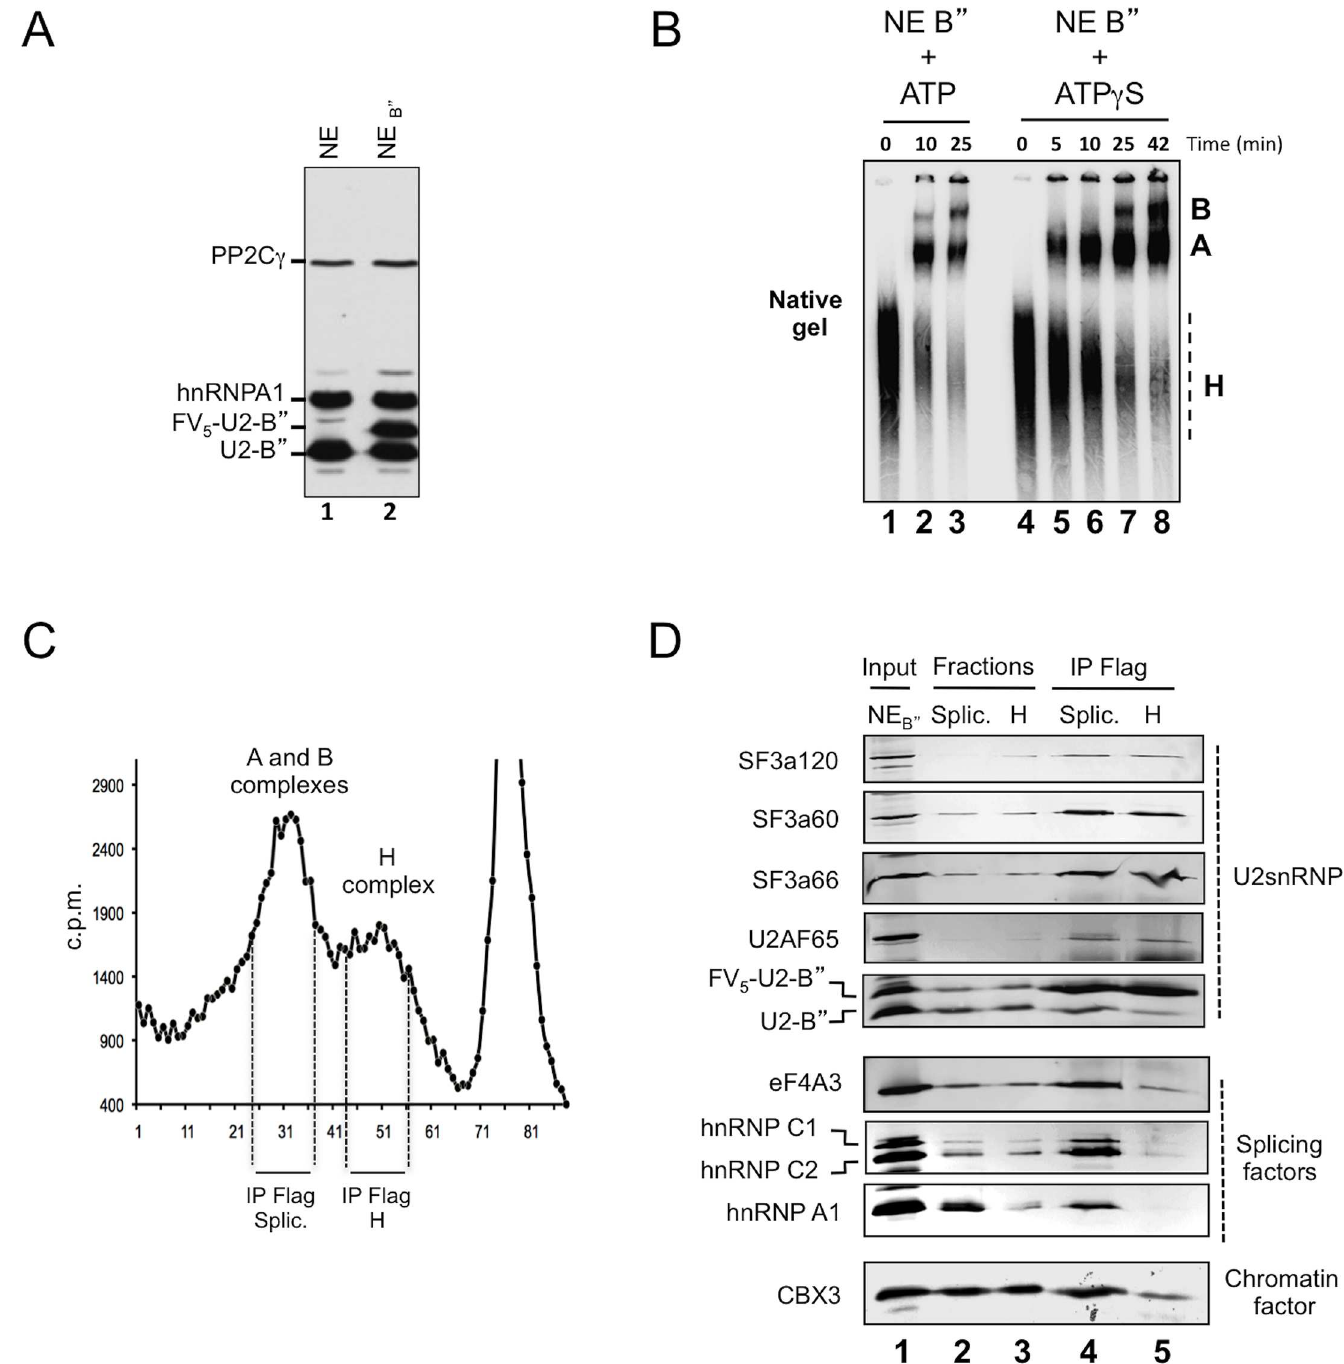
Fig 1. Purificationof spliceosomecomplexesassociatedwiththe U2 snRNP. (A) Detectionby westernblot of indicatedsplicing factors in nuclear extracts fromHeLa S3 cells eitherWT (NE) or stably transducedwith FV 5 -U2-B (NE B” ). (B) Comparison of the kineticand qualityof spliceosome assembly on a radiolabeled AdML pre-mRNAreporterin the presence of eitherATP (lanes1–3) or ATP- γ S (lanes 4–8).Spliceosome complexes A and B were resolved fromunspecificRNP (H complex) on a native gel. (C) Spliceosomecomplexes were purifiedby Sephacryl-S500 gel filtrationfroman in vitro - splicing reactioncomposedof NE B” and radiolabeledAdML reporterincubatedfor 45 min in the presenceof ATP- γ S. Fractions with spliceosome and H complexes selectedfor anti-FLAG immunoprecipitationare indicated. Degraded RNAs and freeproteinsappearin fractions68 to 80. (D) Spliceosome complexes anchoredto the U2 snRNP. NE B” , gel-filtration fractionswith eitherspliceosome (Splic.;lane 2) or H complex (H; lane 3), and the productof the anti-FLAGimmunoprecipitation(lanes4 and 5) were analyzed by westernblot using the indicated antibodies.See also Table 1 and S1D and S1E Fig.